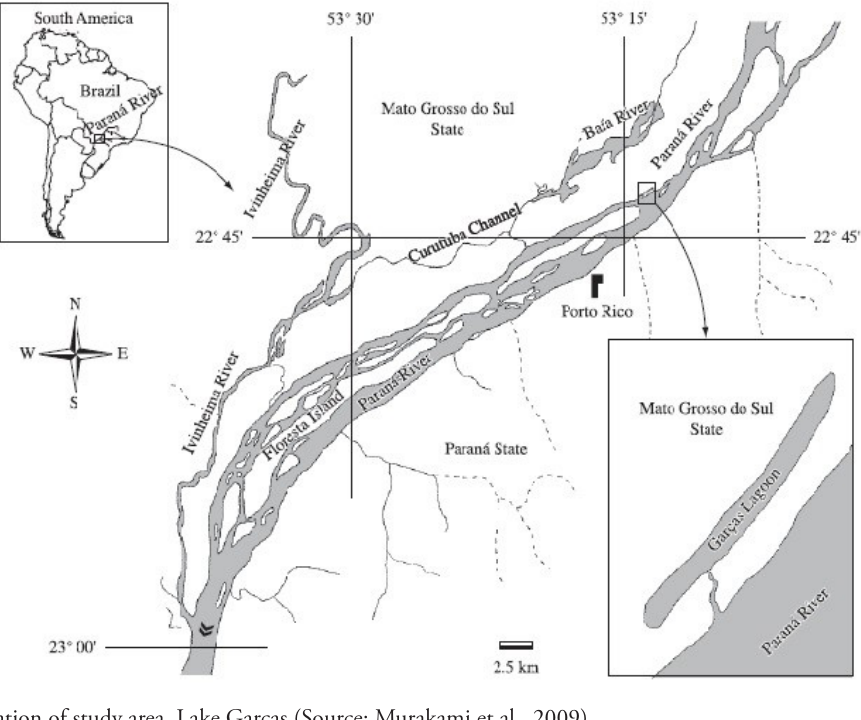
Figure 1. Location of study area, Lake Garças (Source: Murakami et al., 2009).